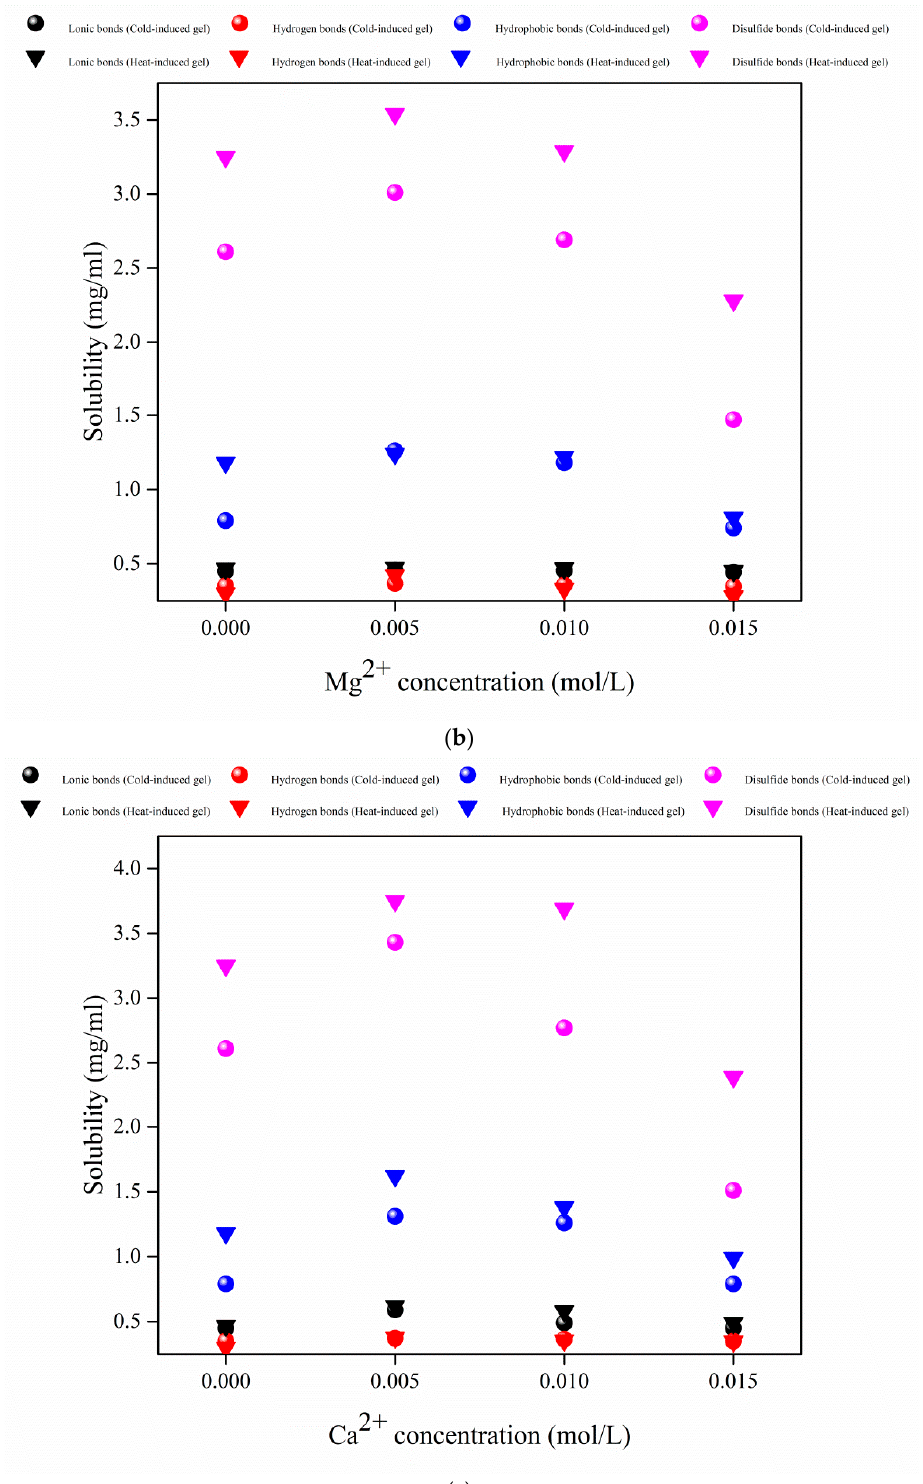
Figure 5. ( a ) Forces in heat- and cold-induced gels formed with Na + (0.005, 0.01, 0.015M) before spray drying; ( b ) Forces in heat- and cold-induced gels formed with Mg 2+ (0.005, 0.01, 0.015M) before spray drying; ( c ) Forces in heat- and cold-induced gels formed with Ca 2+ (0.005, 0.01, 0.015M) before spray drying.